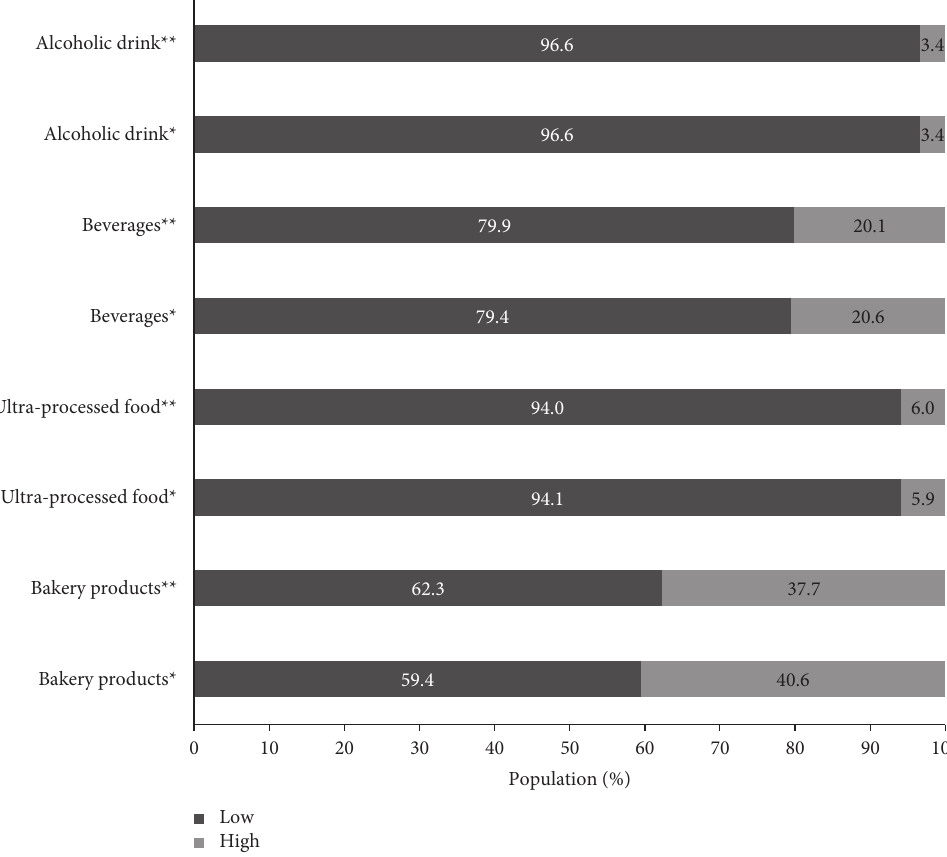
Figure 4: Changes in the frequency of low and high consumption of processed food before and during social isolation. ∗ Before social isolation; ∗∗ during social Table 4: Factors associated with high body mass index during the COVID-19 pandemic in the study sample. Variables